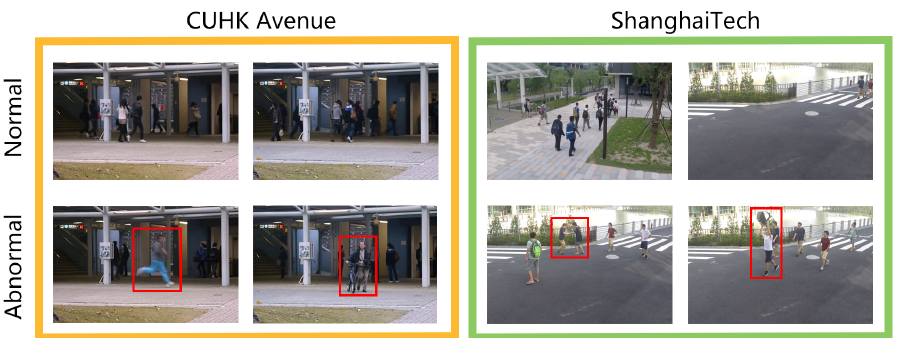
Figure 7. Some normal and abnormal event frames in CUHK Avenue and ShanghaiTech datasets. The abnormal event in the abnormal frame is displayed by the red